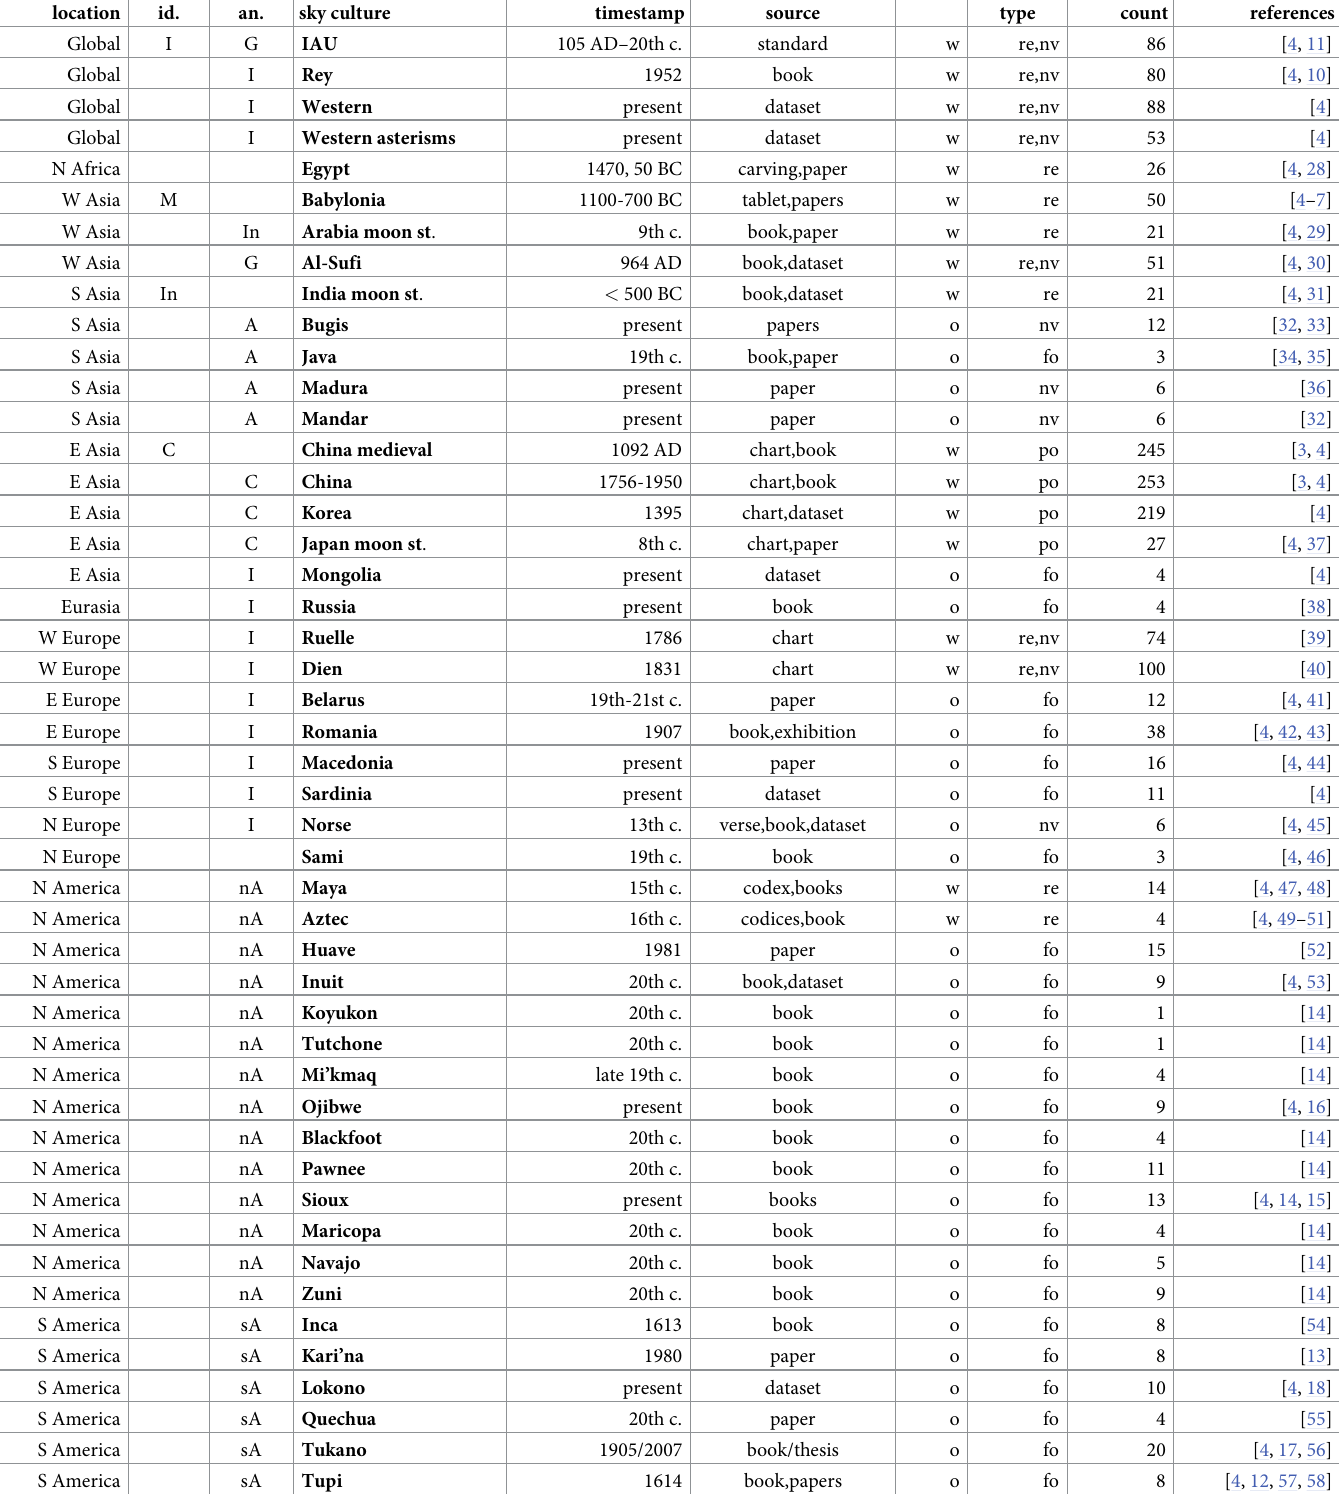
Table 1. Summary of sky cultures.